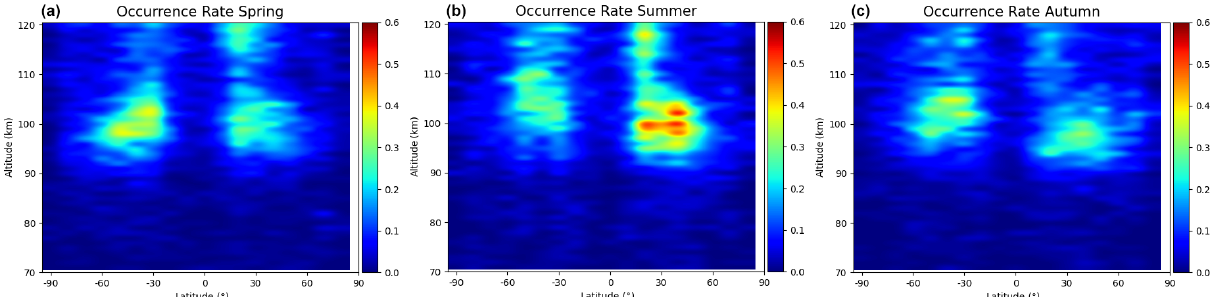
Figure 5. The distribution of E s occurrence rate for three different seasons in 10 ◦ × 1km geographic latitude/altitude grid, (a–c) are the results of spring, summer, and autumn,